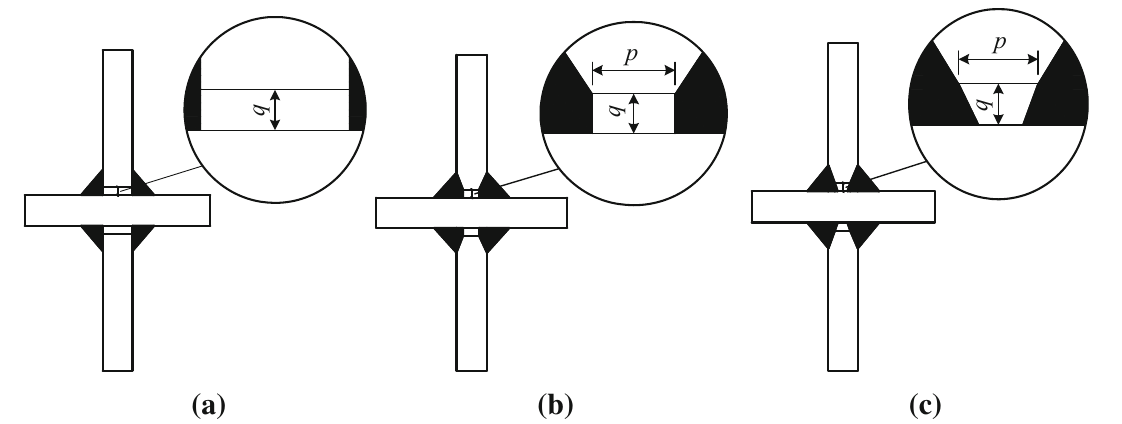
Fig. 11 Schematic diagram of plate gap parameters. a Gap width, b gap length for Type I, c gap length for Type 2